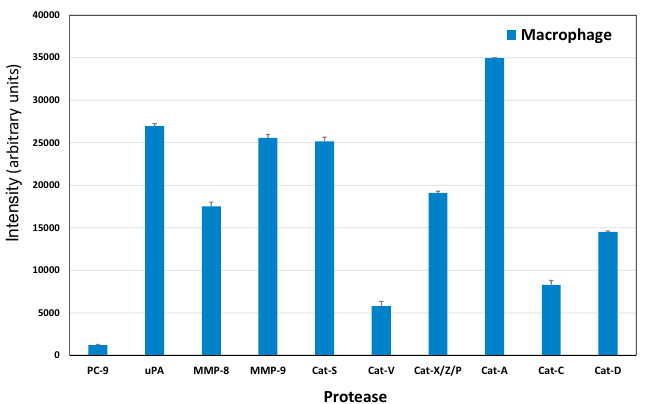
Figure 4. Proteases expressed by macrophages corresponding to the enzymes detected in SCLC lines. Values represent mean ± SD.